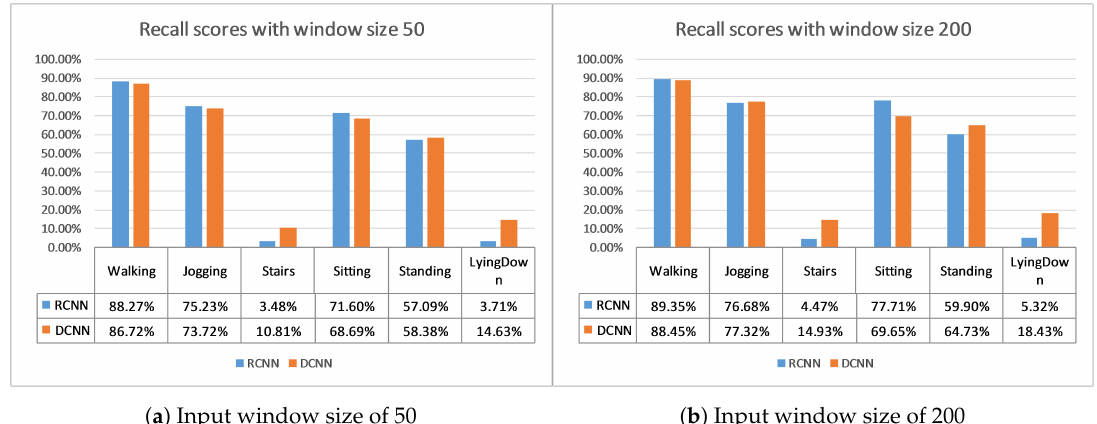
Figure 6. Average recall scores of the 10-fold cross-validation of the Actitracker dataset.